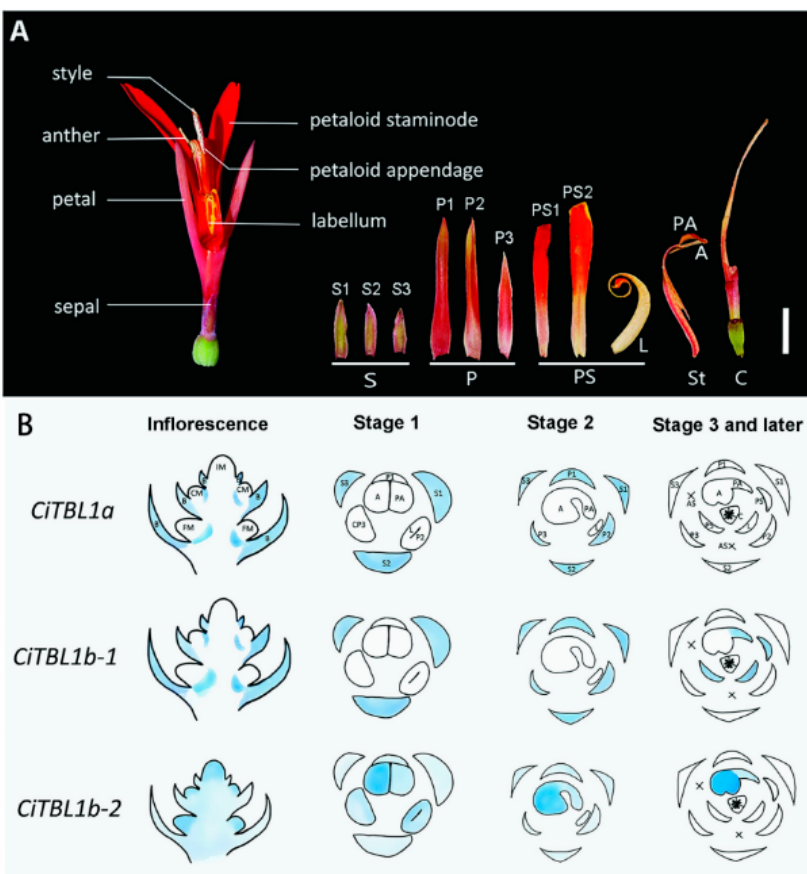
Figure 8. Morphology of Canna indica flowers and expression of CiTBL genes [142] (Yu et al., 2020). ( A ) Flower morphology. A: anthers; C: carpel; L: labellum; P: petals; PA: petaloid appendage; PS: petaloid staminodes; S: sepals; St: staminodes. ( B ) Expression of CiTBL1a , CiTBL1b-1 , and CiTBL1b-2 in young inflorescences and flowers at different developmental stages. Gene expression sites are indicated in blue, with the intensity of the coloration reflecting the expression level. AS: abortive staminodes; B: primary bracts; CM: meristem of monochasium; CP: common primordium of the petal and stamen; FM: floral meristem; IM: inflorescence meristem. Reprinted with permission from Ref. [142]. Copyright © 2023 Frontiers Media S.A.